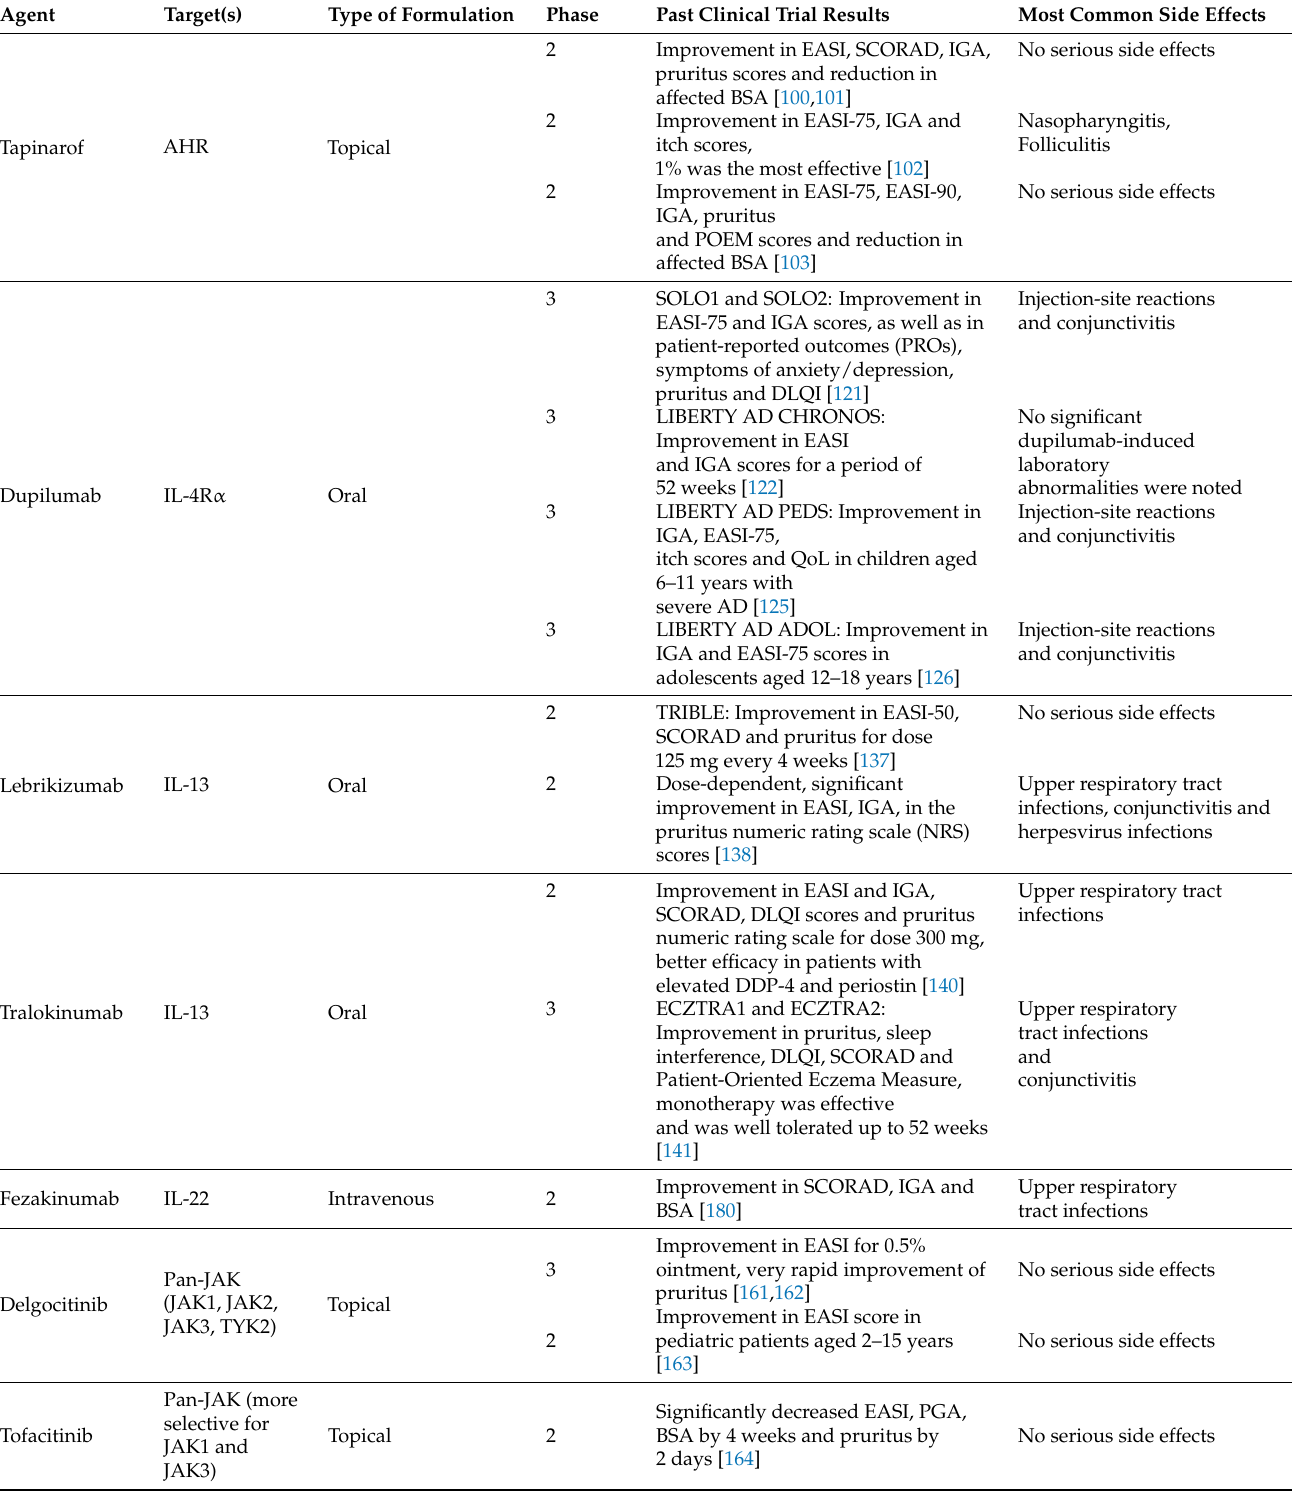
Table 3. Novel topical and systemic targeted therapies of